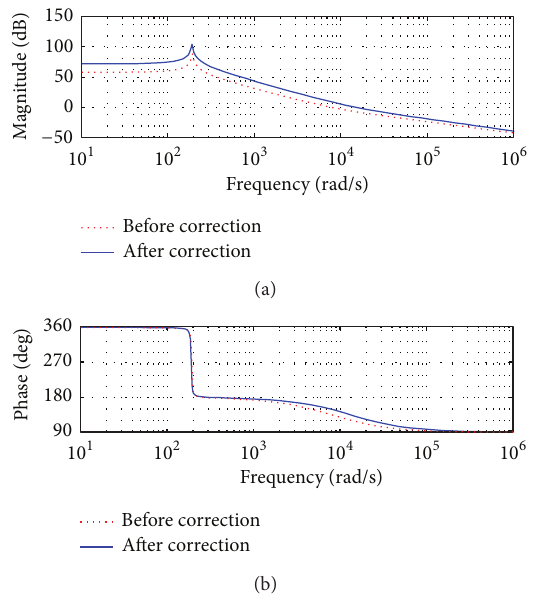
Figure 6: The frequency characteristic of voltage loop in inverter after correction.